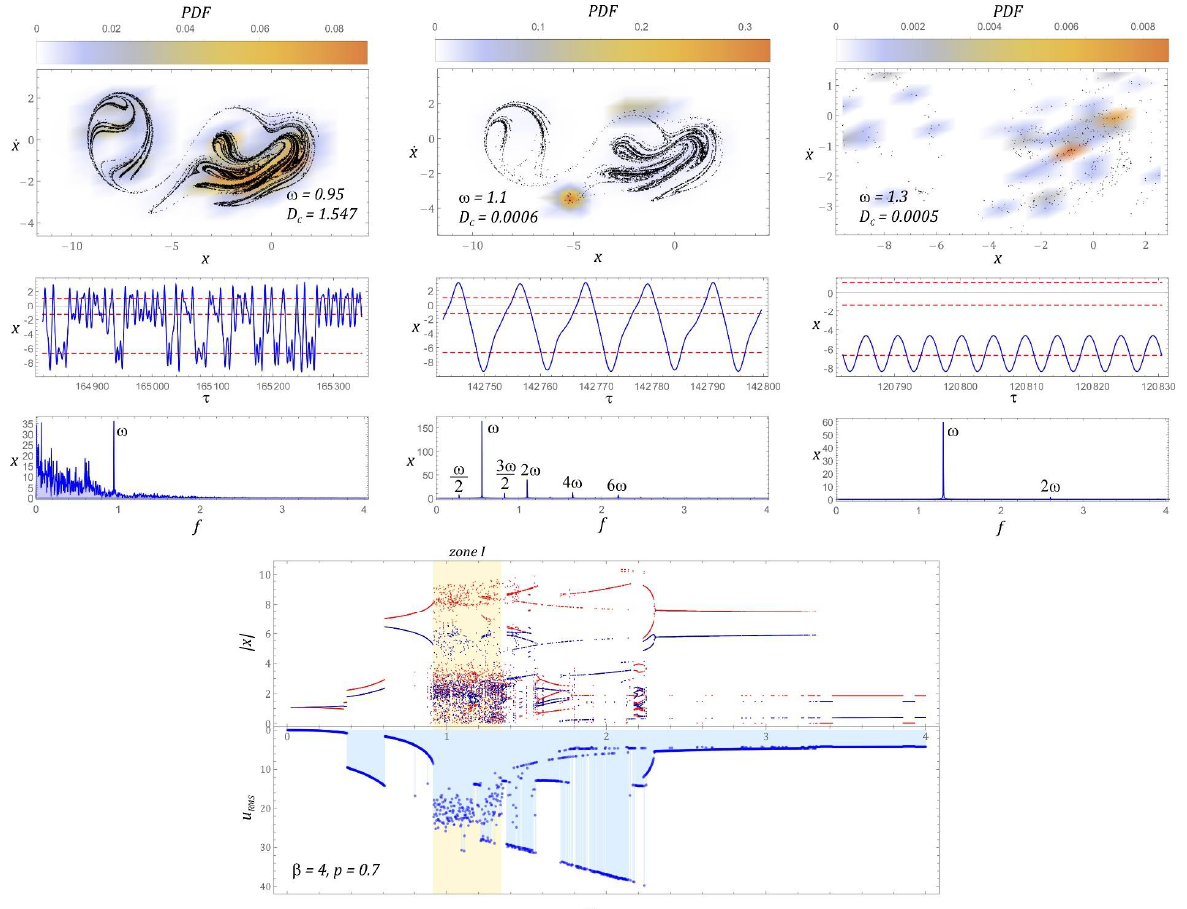
Figure 15. Bifurcation diagram correlated by the frequency spectra with the diagram of RMS voltage output induced on piezoelectric electrodes and examples of chaotic responses (Poincaré maps with correlation dimension and probability density function (PDF) indicated).